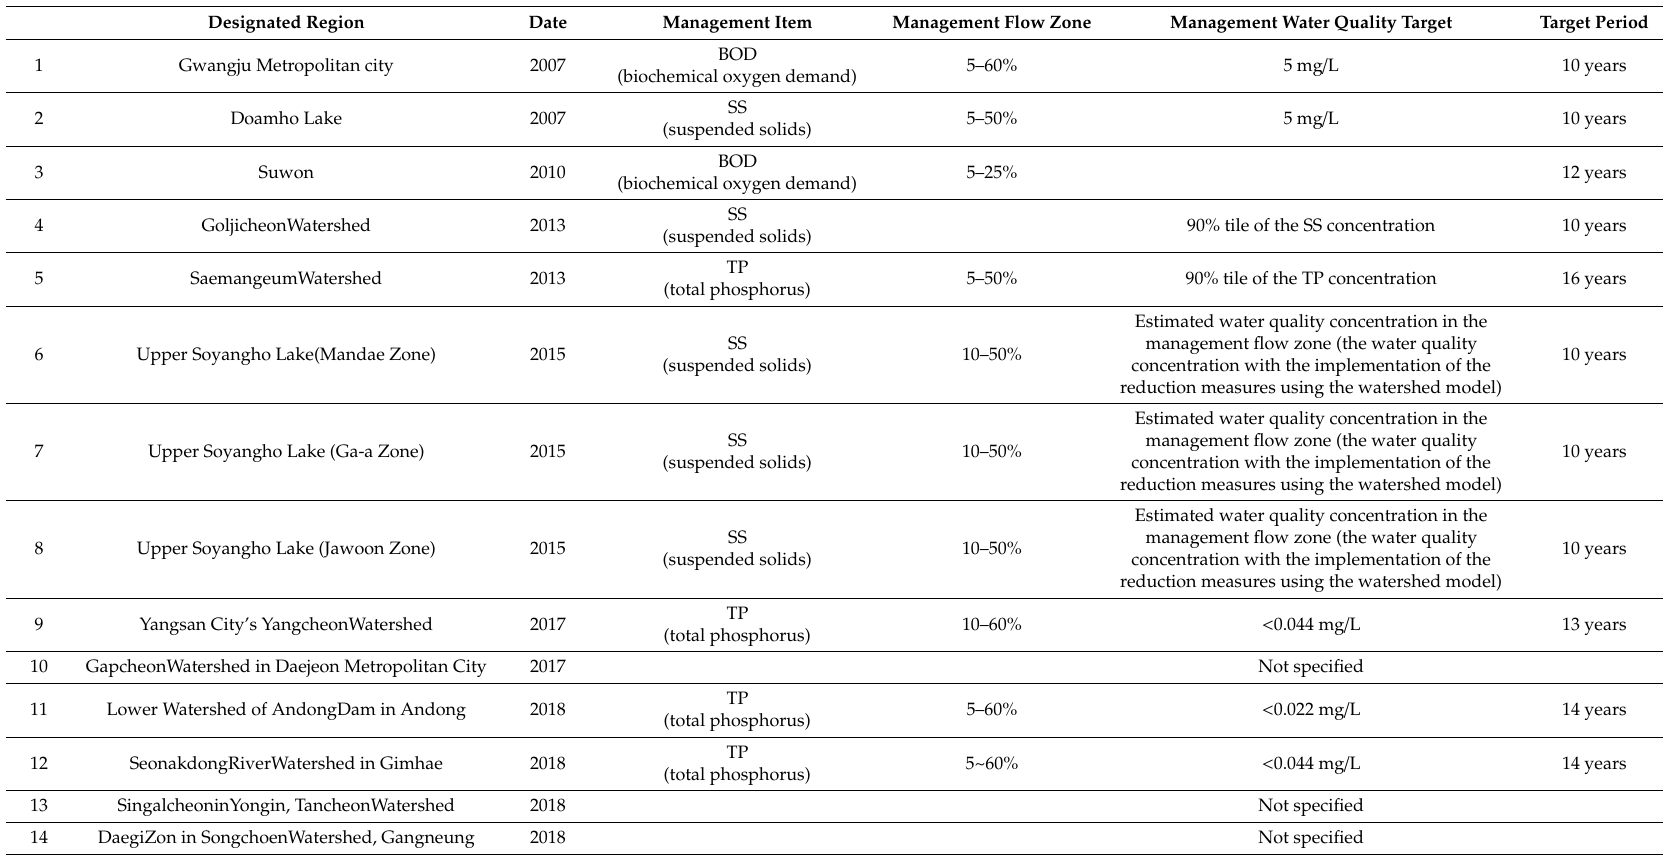
Table 1. Current status of the NPS management regions in